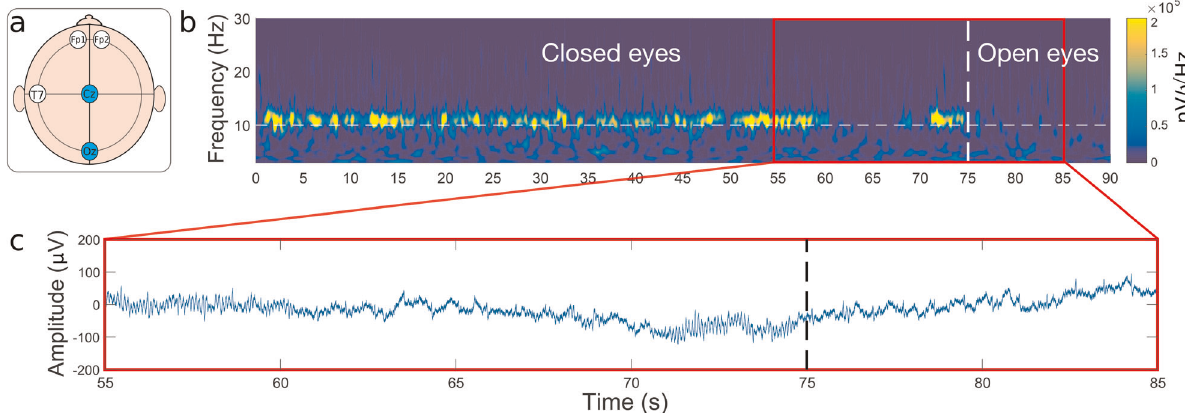
Fig. 2 Electroencephalography recording with TTEs on human scalp. a Schematic mapping of the electrodes localization on the head, according to the 10 – 20 international system, with highlighted Cz – Oz derivation adopted for the recordings of spontaneous brain activity. b Time – frequency plot with visible Alpha activity at 10 Hz. Alpha waves momentarily disappeared for 10 s, as the subject heard an environmental noise while still in relaxing phase. At 75 s, the participant was directly asked to open his eyes (distinct by vertical white dotted line). c The amplitude-time plot near 75 s. The EEG recording shows alpha waves oscillations from 55 to 60 s and from 71 to 75 s, representing wakeful relaxation